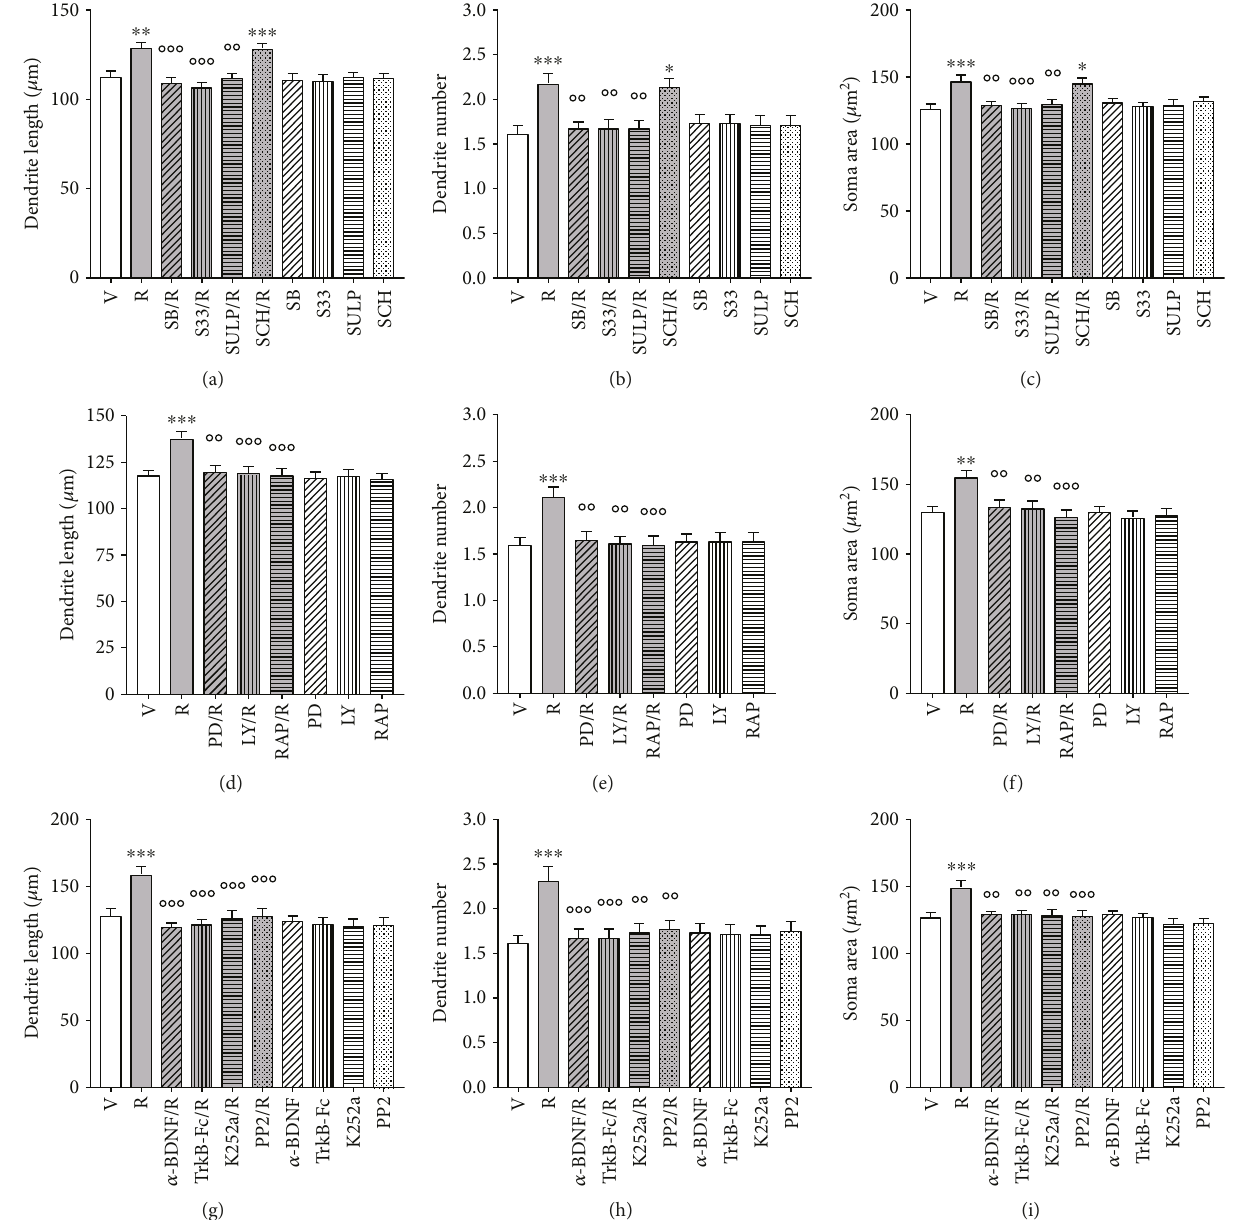
Figure 4: Structural plasticity induced by ropinirole in human iPSC-derived DA neurons is prevented by D3R antagonists, by MEK-ERK and PI3K-mTOR inhibitors and by BDNF-TrkB signaling inhibitors. (a – c) Inhibition of the e ff ects of ropinirole (10 μ M) on structural plasticity of F3 DA neurons following pretreatment (20 min) with the D3R antagonists SB277011-A (50 nM) and S33084 (10 nM) or the D2/D3R antagonist sulpiride (5 μ M) assessed as (a) maximal dendrite length, (b) number of primary dendrites, and (c) soma area after 72 hrs. Pretreatment (20 min) with the D1R antagonist SCH23390 (1 μ M) was ine ff ective. (d – f) Inhibition of the e ff ects of ropinirole (10 μ M) on structural plasticity of F3 DA neurons following pretreatment (20 min) with PD98059 (10 μ M), LY294002 (10 μ M), or rapamycin (20 nM), assessed as (d) maximal dendrite length, (e) number of primary dendrites, and (f) soma area after 72hrs. (g – i) Inhibition of the e ff ects of ropinirole (10 μ M) on structural plasticity of F3 DA neurons following pretreatment (20 min) with an anti-BDNF blocking antibody ( α - BDNF) (10 μ g/ml), a TrkB-Fc Chimera (TrkB-Fc) (5 μ g/ml), the TrkB-phosphorylation inhibitor K252a (200nM), and the TrkB-Src phosphorylation inhibitor PP2 (10 μ M), assessed as (g) maximal dendrite length, (h) number of primary dendrites, and (i) soma area after 72hrs. When antagonists and inhibitors were tested with the vehicle, no changes of structural plasticity were visualized. In all panels, values are represented as mean ± SEM ( ∗∗∗ p < 0 001 , ∗∗ p < 0 01 , and ∗ p < 0 05 versus vehicle; °°° p < 0 001 and °° p < 0 01 versus ropinirole; post hoc Bonferroni ’ s test). V, vehicle; R, ropinirole; SB, SB277011-A; S33, S33084; SULP, sulpiride; SCH, SCH23390; PD, PD98059; LY, LY294002; RAP, rapamycin, α -BDNF, anti-BDNF blocking antibody; TrkB-Fc, TrkB-Fc